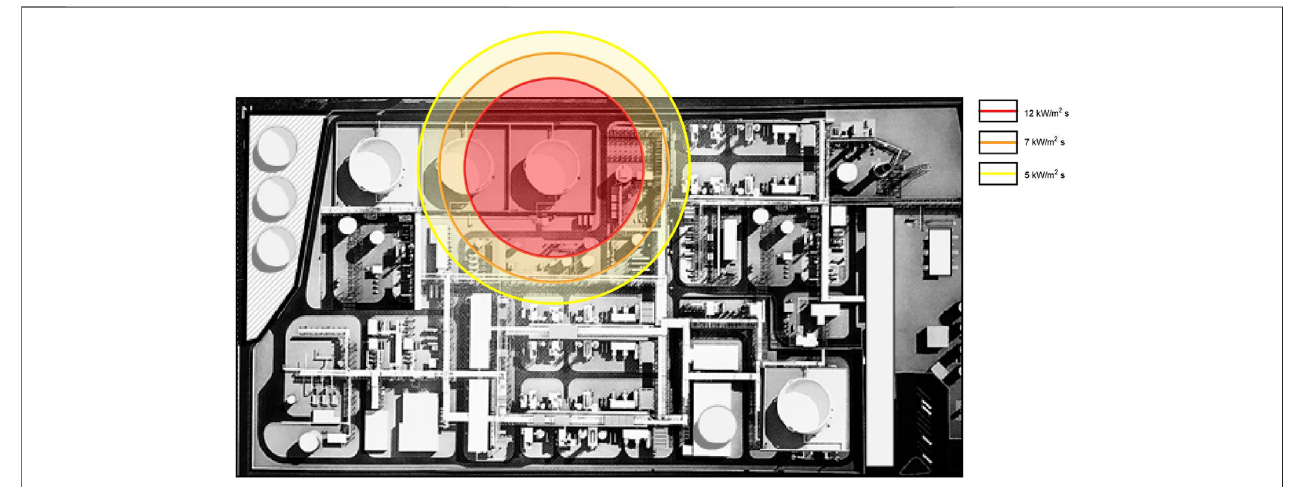
FIGURE 11 | Contour lines of the impact: LOC2 scenario due to the oil spillage from a storage tank.